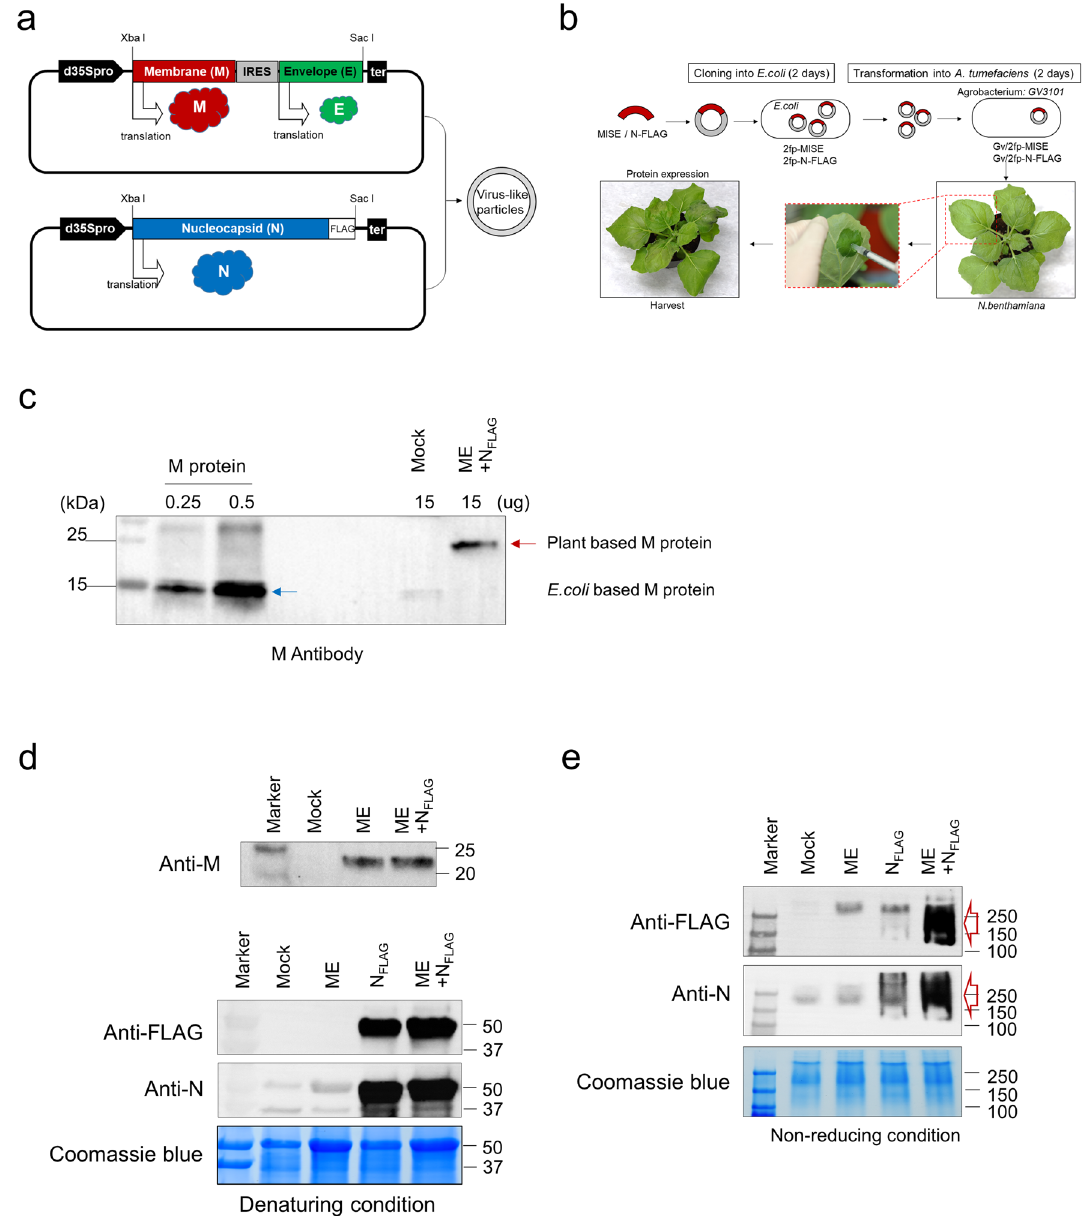
Figure 1. Expression of SARS-CoV-2 VLPs in N. benthamiana . ( a ) Schematic representation of two vectors for the formation of SARS-CoV-2 VLPs. pBYR2fp-M IRES E (upper) and pBYR2fp-N FLAG (bottom) vectors contained a recombinant gene, M-IRES-E (M IRES E) and N-FLAG (N FLAG ). ( b ) Schematic representation of the co-expression system process by two vectors using the agroinfiltration method in tobacco plants. ( c ) Identification of M protein (~ 25 kDa) expression using Western blot analysis in total soluble protein (TSP) extracted from tobacco leaves 3 dpi of pBYR2fp-M IRES E. Recombinant M protein (15 kDa) derived from E. coli used as a positive control was loaded with 0.25 µg (line 2) and 0.5 µg (line 3), respectively. ME represents samples injected with pBYR2fp-M IRES E. Western blot analysis under both denaturating ( d ) and non-denaturating conditions ( e ) to confirm the co-expression of M, E, and N in TSP. N FLAG represents samples injected with pBYR2fp-N FLAG . ME + N FLAG represents samples co-injected with pBYR2fp-M IRES E and pBYR2fp- N FLAG. All images were cropped. See Supplementary Figs. S1–S3 for full size of